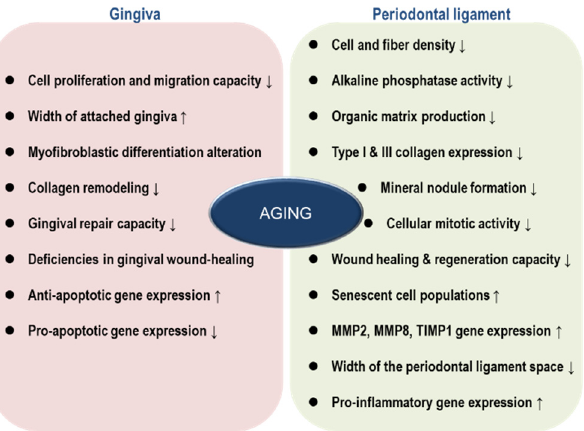
Figure 1. Physiological and biochemical changes in gingiva and periodontal ligament during aging.